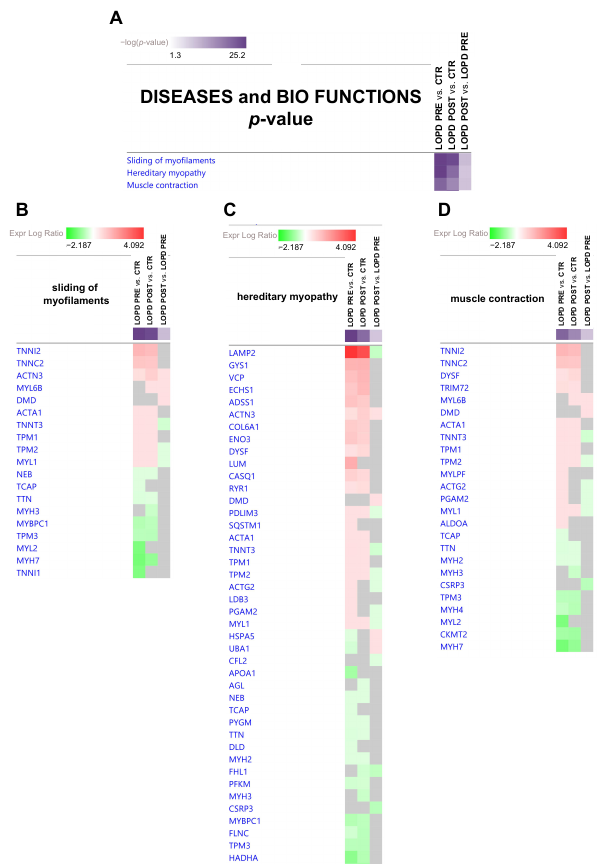
Figure 5. ( A ) Diseases and bio functions heatmap displaying the most significant results ( p -value, Table S5) across datasets in LOPD PRE vs. CTR, LOPD POST vs. CTR, and LOPD POST vs. LOPD PRE. ( B , C , D ) Gene heatmap enables to visualize protein expression data in a specific disease and biofunction, across multiple analyses at one time. Green and red colors refer to decrease or increase for each individual protein statistically changed in our proteomics dataset. Grey color indicates changes statistically non-significant for p -value (ANOVA followed by Tukey’s post-hoc test ( p < 0.05)). Dots are non-significant values for z-score (z-score ≥ 2, ≤ −